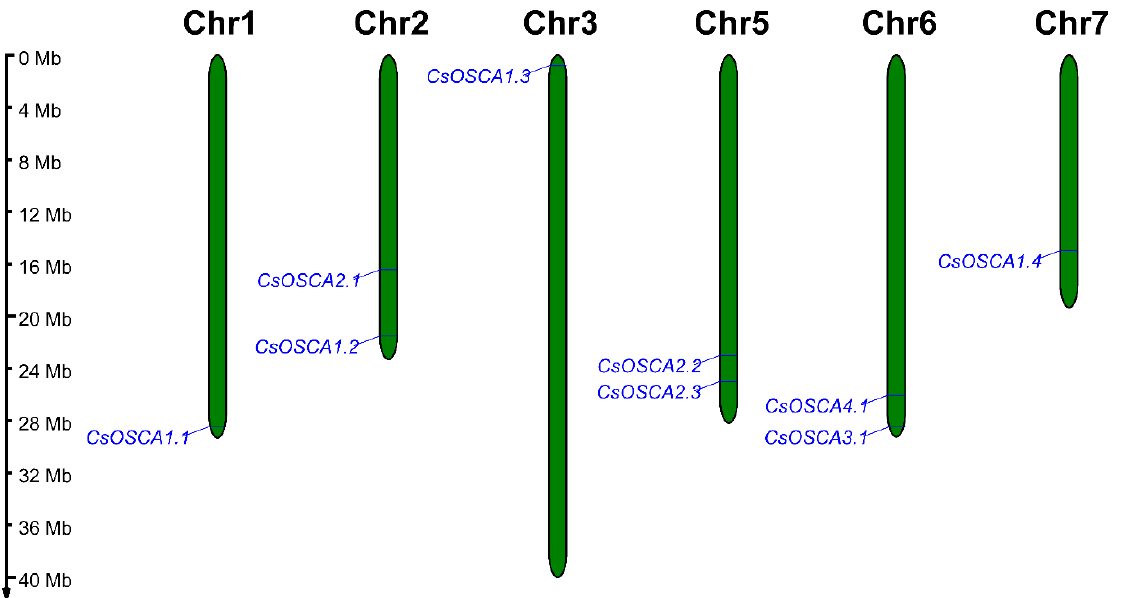
Figure 3. Distribution of the CsOSCA genes on six cucumber chromosomes. The scale on the left represents megabases (Mb).